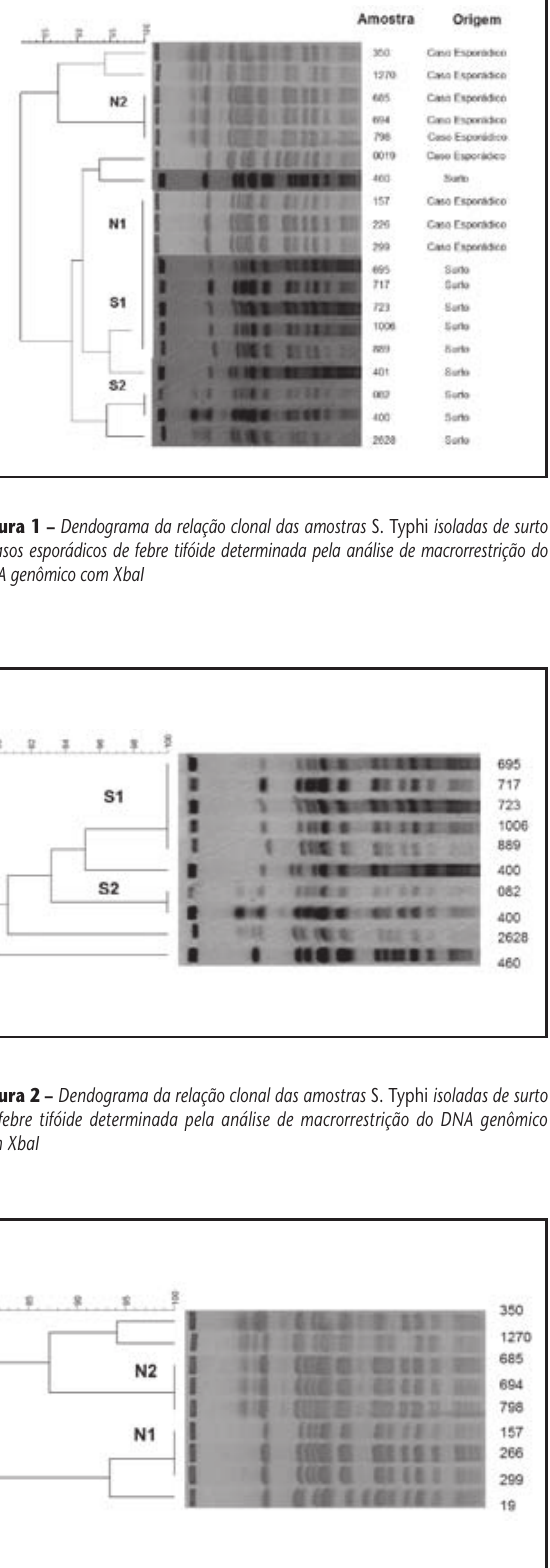
Figura 3 – Dendograma da relação clonal das amostras S. Typhi isoladas de casos esporádicos de febre tifóide determinada pela análise de macrorrestrição do DNA genômico com XbaI